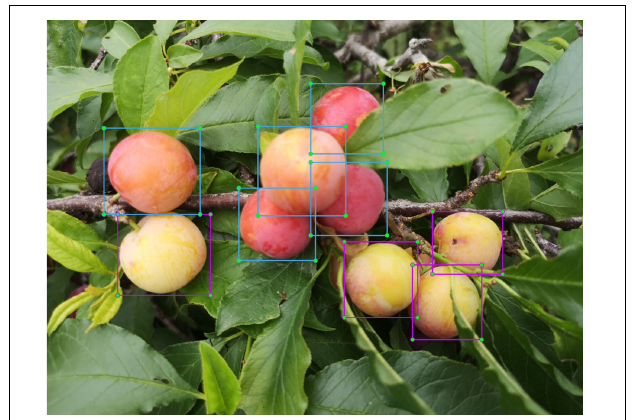
FIGURE 2 | Data annotation example: the blue box represents mature plums, and the purple box represents immature plums.